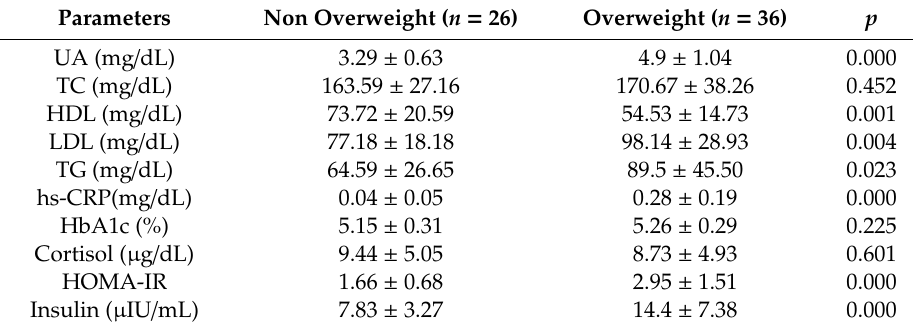
Table 2. Comparison of biochemical data between non-overweight and obese